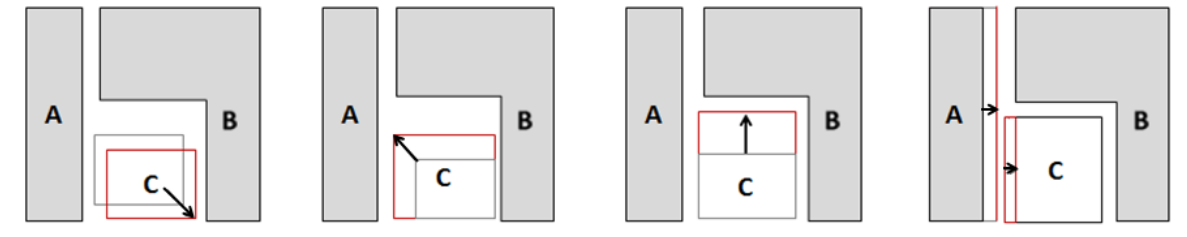
Figure 3. Proposal moves. Room displacement ( left ), corner adjustment ( centre left ), wall adjustment ( centre right ), shared wall adjustment ( right